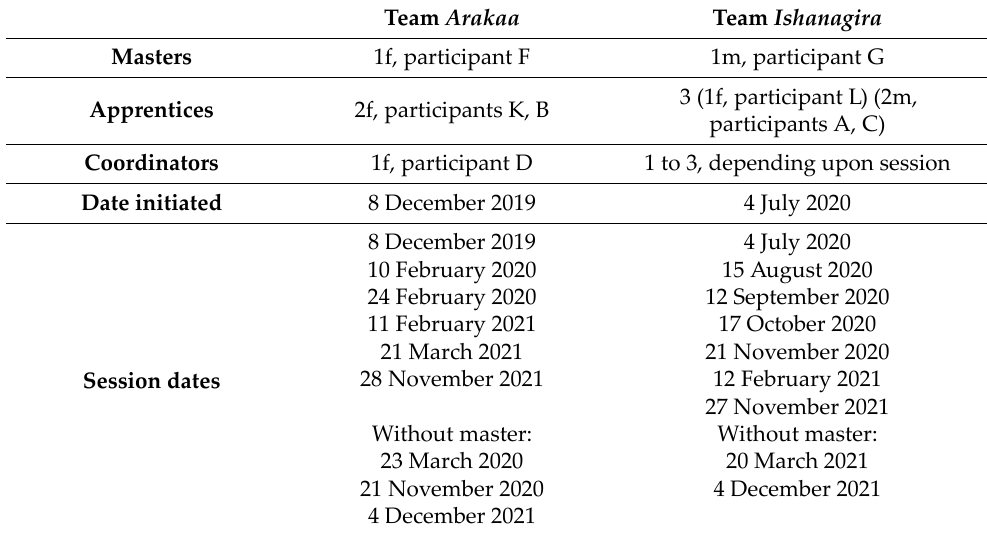
Table 1. MA team formation and sessions